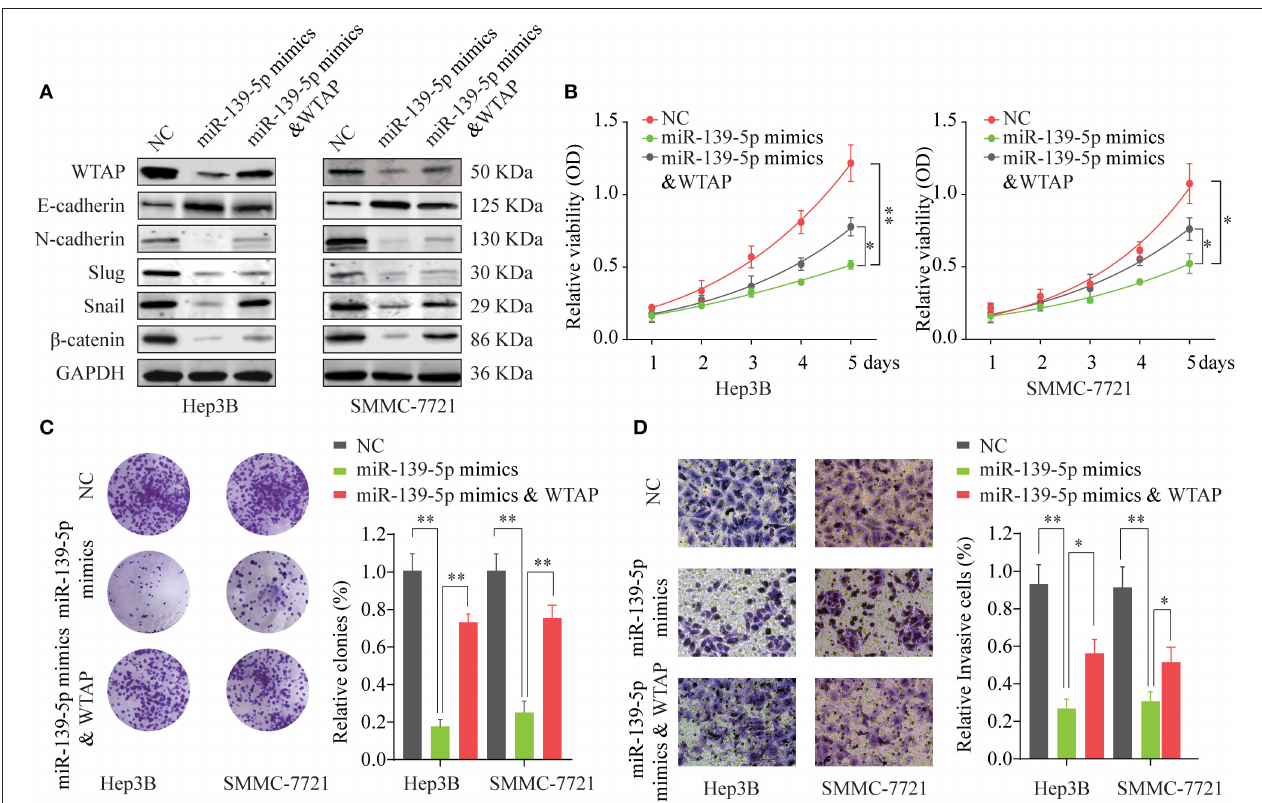
FIGURE 7 | Overexpression of miR-139-5p inhibits the cell proliferation and invasion by targeting WTAP. Hep3B or SMMC-7721 cells were transfected with NC, miR-139-5p mimics or miR-139-5p mimics, and the WTAP overexpression plasmid. (A) The expression levels of E-cadherin, N-cadherin, Slug, Snail, and β -catenin were analyzed by western blot 48h later. GAPDH was used as a loading control. (B,C) Cell proliferation was determined by the CCK-8 cell proliferation assay (B) and the colony formation assay (C) . (D) The cell invasion capability of Hep3B or SMMC-7721 cells in the different groups was analyzed by the Transwell assay. * p < 0.05, ** p <